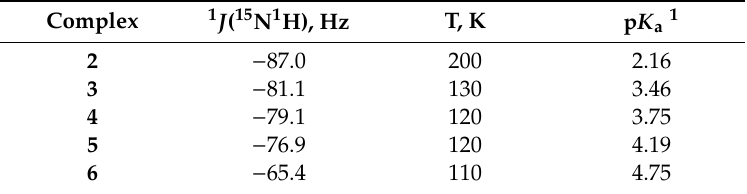
Table 1. Experimental 1 J ( 15 N 1 H) scalar couplings in 2 – 6 in CDF 3 /CDClF 2 solution [46].